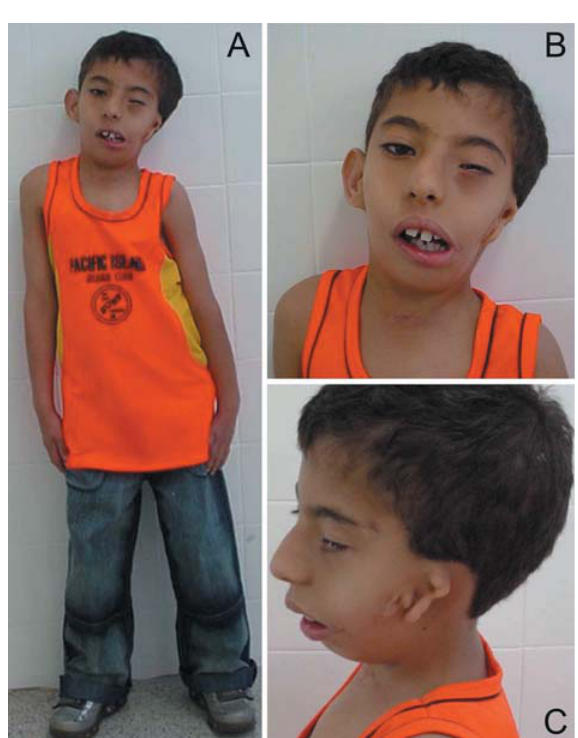
Figure 2- Skeletal and facial phenotypes of patient #2 of this study. (A) Anterior standing photograph of the patient, demonstrating severe lordoscoliosis. (B) Frontal view of